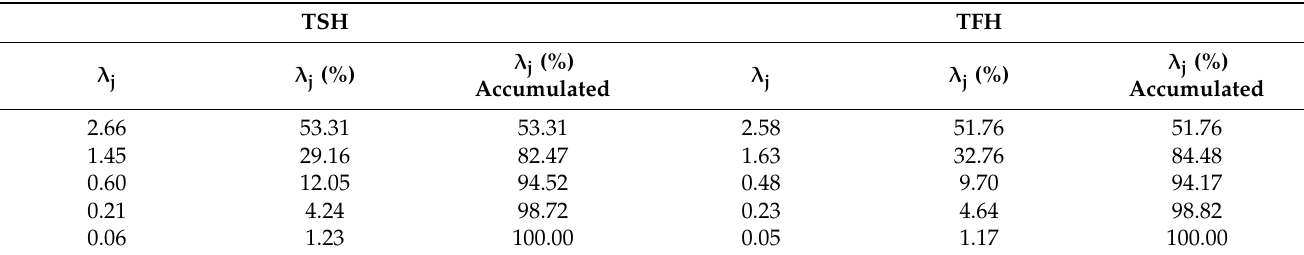
Table 9. Estimates of eigenvalues and cumulative percentage of variance explained by the main components of the original data referring to the agro-industrial performance (TSH and TFH) of 20 sugarcane genotypes evaluated in the five microregions of the state of